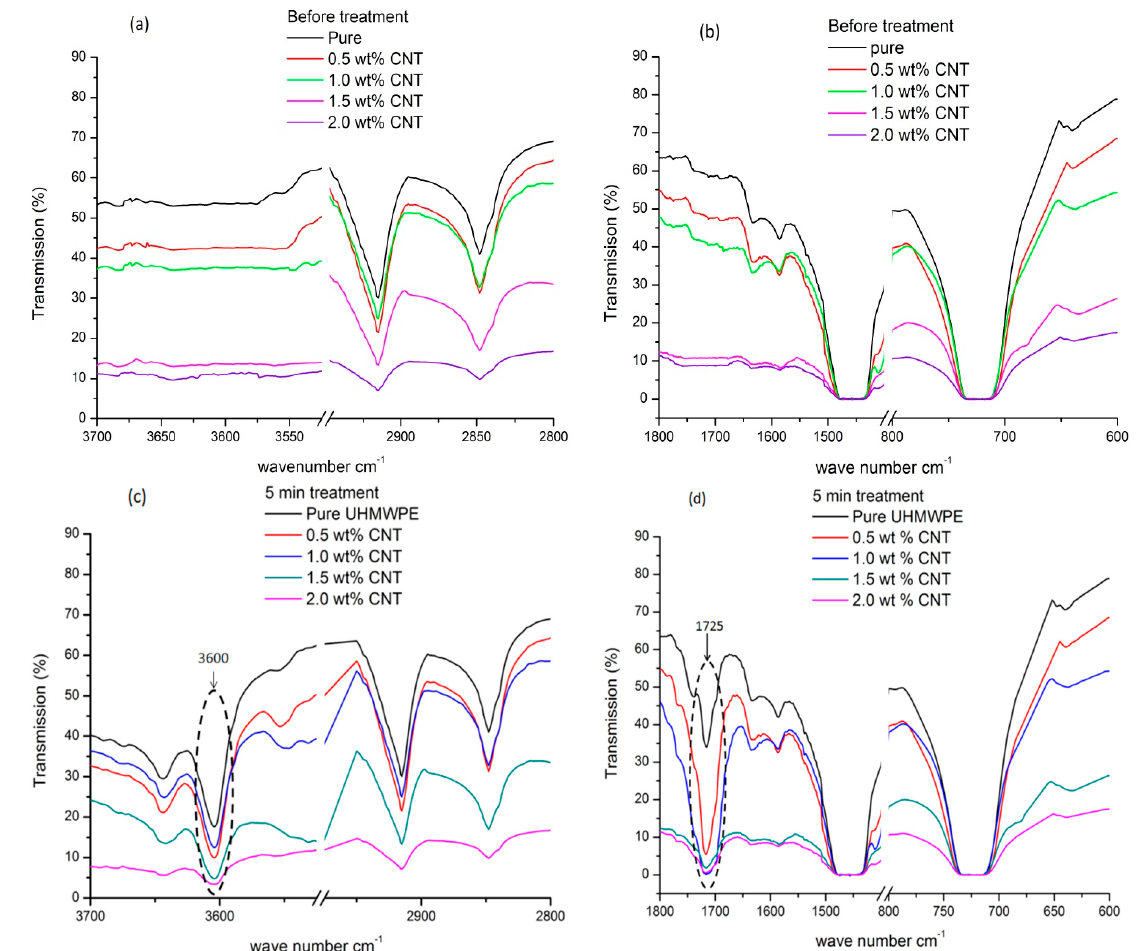
Figure 3. FTIR-ATR spectra of before plasma treatment ( a ) and ( b ); 5 min plasma-treated sample ( c ) showing 2850, 2920, and 3600 peaks; and ( d ) showing 722, 1465, and 1723 peaks.